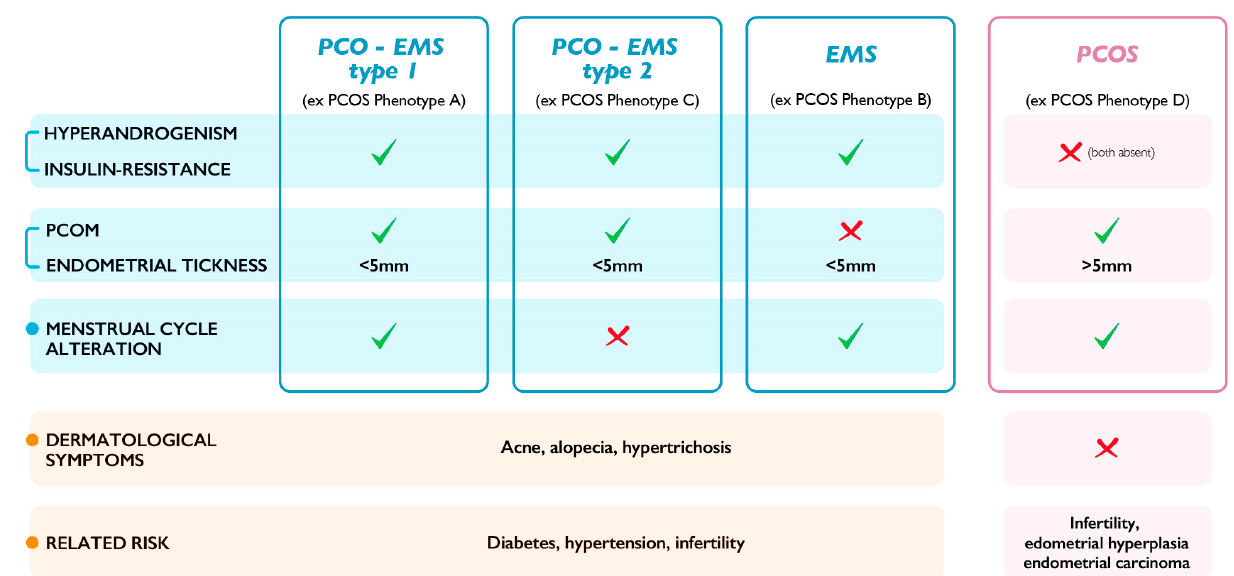
Figure 2. New classification for PCOS. PCOS (polycystic ovary syndrome), EMS (endocrine–metabolic syndrome), PCOM (polycystic ovarian morphology), and PCO (polycystic ovary). New combina- tions of different parameters indicate the phenotypes of an innovative PCOS classification. PCOS phenotype A is updated as “PCO-EMS type 1” with the presence of both hyperandrogenism and insulin resistance, the presence of PCOM and an endometrial thickness < 5 mm, and the presence of menstrual cycle alterations; PCOS phenotype C is updated as “PCO-EMS type 2” with the presence of both hyperandrogenism and insulin resistance, the presence of an endometrial thickness < 5 mm and PCOM, and the absence of menstrual cycle alterations; PCOS phenotype B is updated as “EMS” with the presence of both hyperandrogenism and insulin resistance, the presence of an endometrial thickness < 5 mm and the absence of PCOM, and the presence of menstrual cycle alterations. Subjects presenting PCO-EMS type 1, PCO-EMS type 2, and EMS share the same dermatological symptoms (acne, alopecia, and hypertrichosis) and the same related risk (diabetes, hypertension, and infertil- ity). PCOS phenotype D is updated as “PCOS” with the absence of both hyperandrogenism and insulin resistance, the presence of PCOM and an endometrial thickness > 5 mm, and the presence of menstrual cycle alterations. Subjects with PCOS do not exhibit dermatological symptoms and share related risks (infertility, endometrial hyperplasia, and endometrial carcinoma) differing from those in subjects with EMS. ✓ : feature present; X: feature